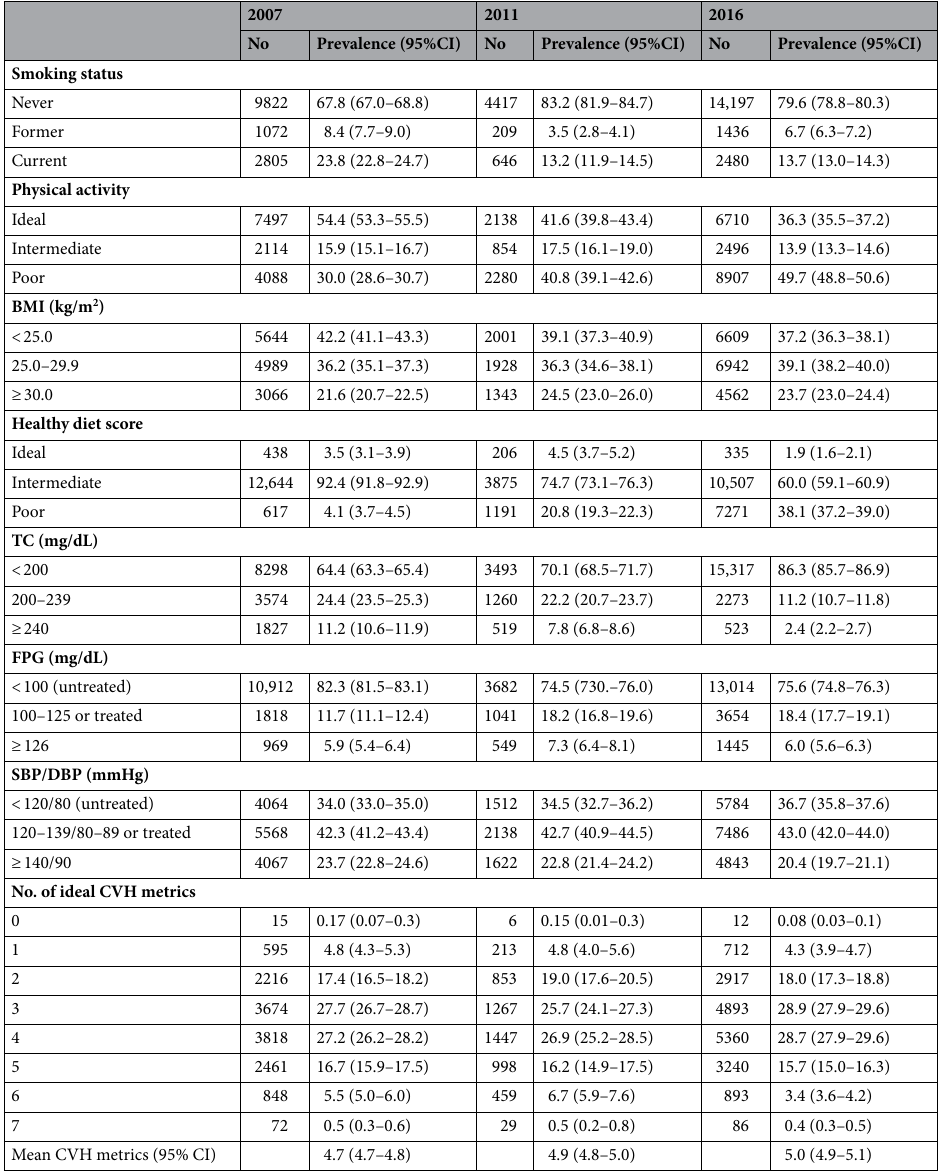
Table 3. Prevalence of cardiovascular health metrics in adults in STEPS 2007, 2011, 2016. Data from each survey is weighted for age, sex, area of residence, on the basis of the Iranian census population 2011. STEPS, STEPwise approach to surveillance; CI, confidence interval; BMI, body mass index; TC, total cholesterol; FPG, fasting plasma glucose; SBP, systolic blood pressure; DBP, diastolic blood pressure; CVH metrics, cardiovascular health index. SI conversion factors: to convert total cholesterol values to mmol/L, multiply by 0.0259; to convert glucose values to mmol/L, multiply by